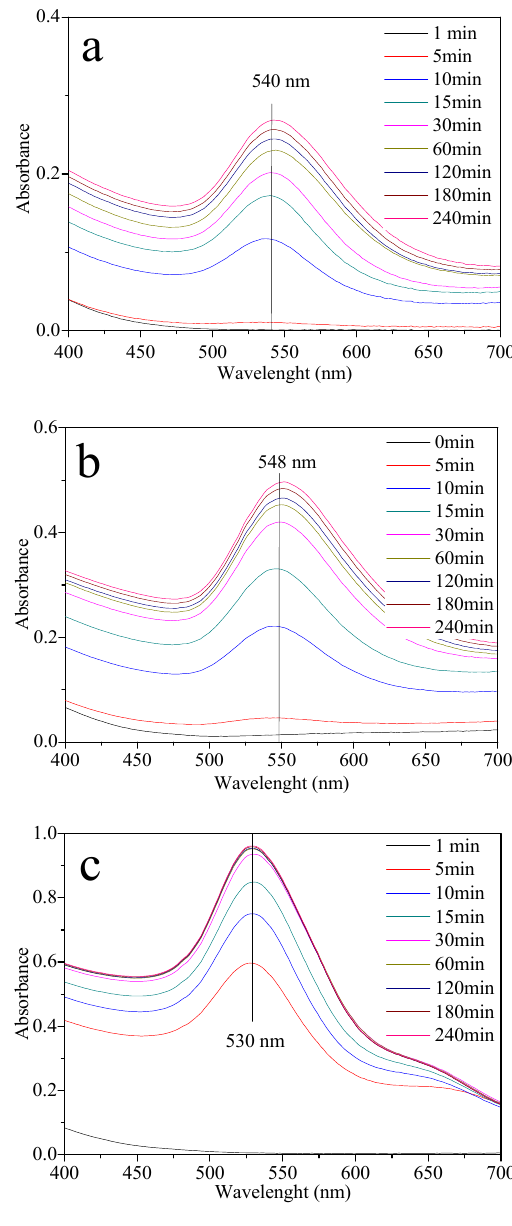
Figure 5. UV-Vis spectra of AuNPs using only Pluronic P103: ( a ) AuNPs P103 0.5%; ( b ) AuNPs P103 1%, and ( c ) AuNPs P103 10%, all synthesized at 30 °C.